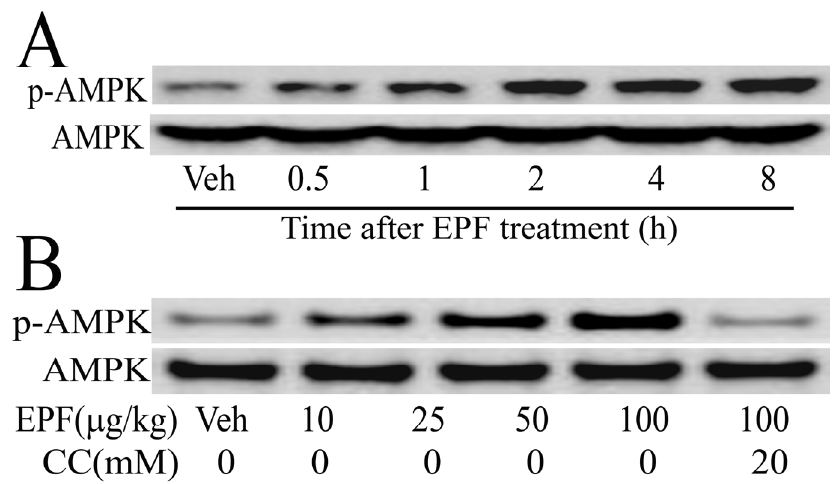
Figure 3. Western blot analysis of protein expression levels of AMPK in HepG2 cells: ( A ) cellular extracts were collected at the indicated times after treatment of EPF (100 μ g/mL); and ( B ) cellular extracts were collected at 4 h after EPF treatment (10–100 μ g/mL).